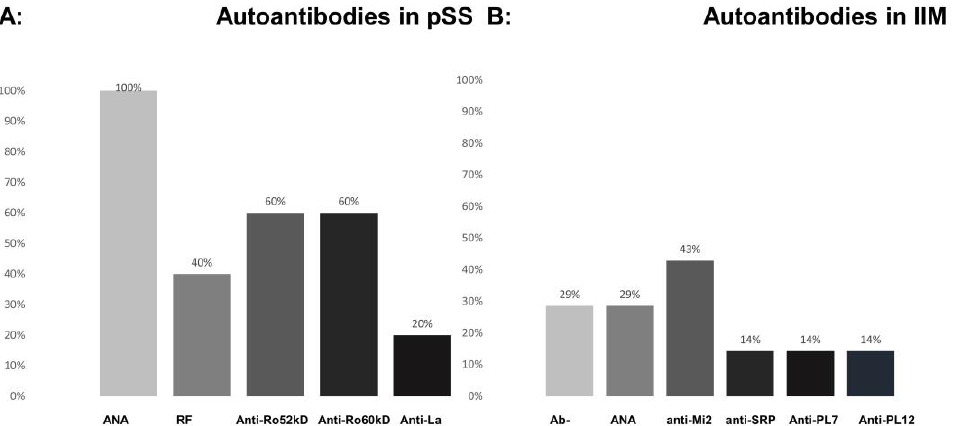
Figure 2. Autoantibody positivity in Fibromyalgia patients diagnosed as having a Connective Tissue Disease Legend: ( A , B ): seronegative patients; ANA: Antinuclear Antibodies; CTD: Connective Tissue Disease; IIM: Idiopathic Inflammatory Myopathy; pSS: primary Sjögren’s Syndrome; RF: Rheumatoid Factor.